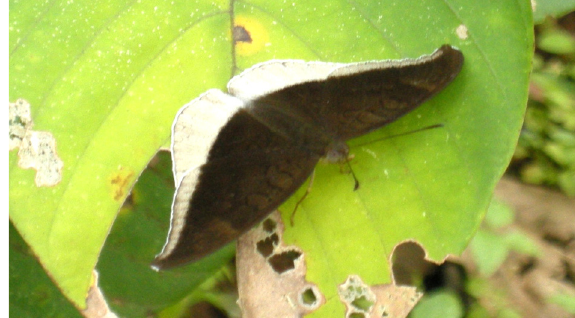
Image 5. Grey Count Tanaecia lepidea - male